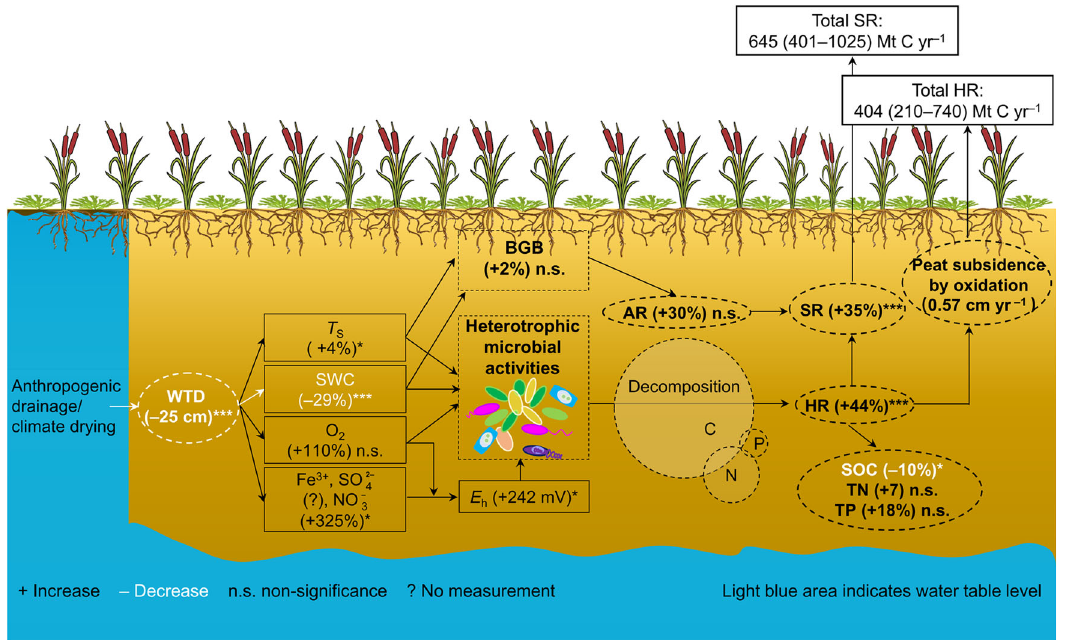
Fig. 8 Conceptual model describing the effects of WT decline on soil carbon emissions and peat subsidence from global pristine peatlands. SR (soil respiration), HR (heterotrophic respiration), AR (autotrophic respiration), WTD (water table depth), T s (soil temperature), SWC (soil water content), O 2 ð soilsulfateconcentration Þ , NO (cid:1) (soil oxygen content), Fe 3 + (soil trivalent iron concentration), SO 2 (cid:1) (soil nitrate concentration), E h (soil redox potential), 4 3 BGB (belowground biomass), SOC (soil organic carbon concentration), TN (total nitrogen concentration) and SP (soil phosphorus concentration). The asterisks *, **, *** indicate signi fi cance at the levels of p < 0.05, 0.01 and 0.001, respectively, and n.s. indicates no signi fi cance (for details, see Meta- analysis in Methods). The total SR and HR are presented as the means with 95% con fi dence intervals (for estimation details, see